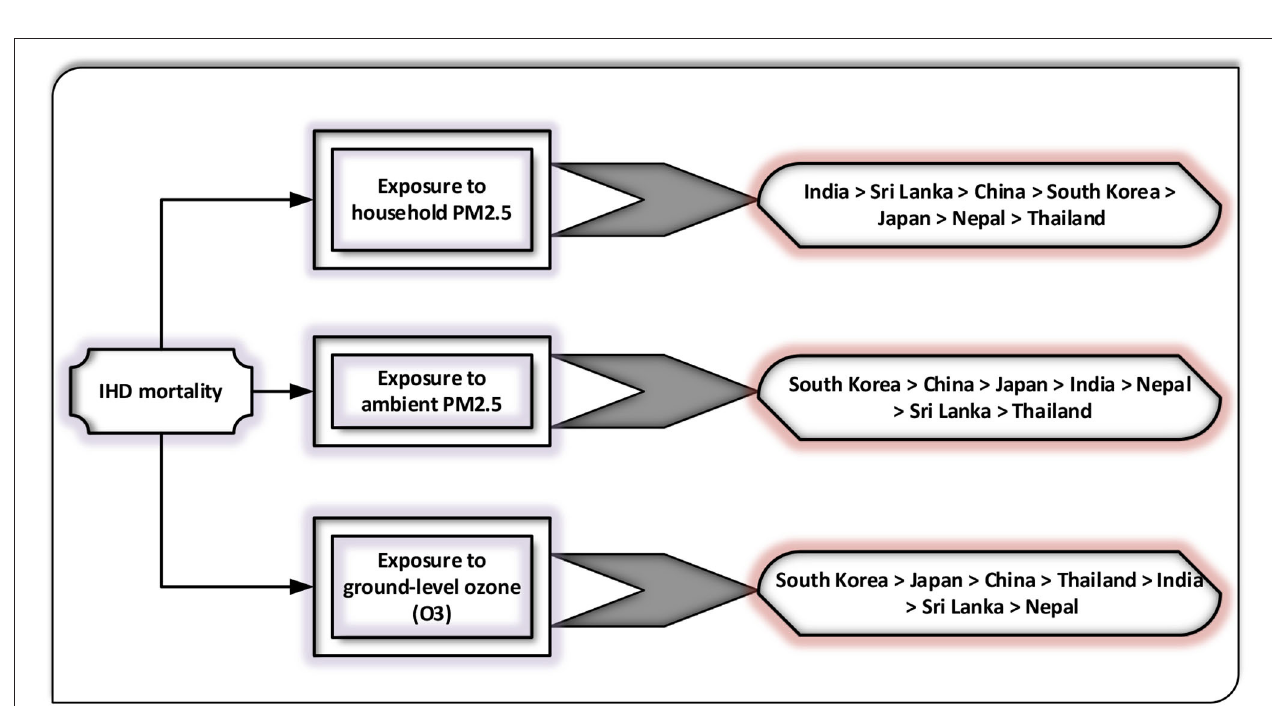
FIGURE 4 | The ranking order of selected Asian countries is based on grey relational analysis (GRA).